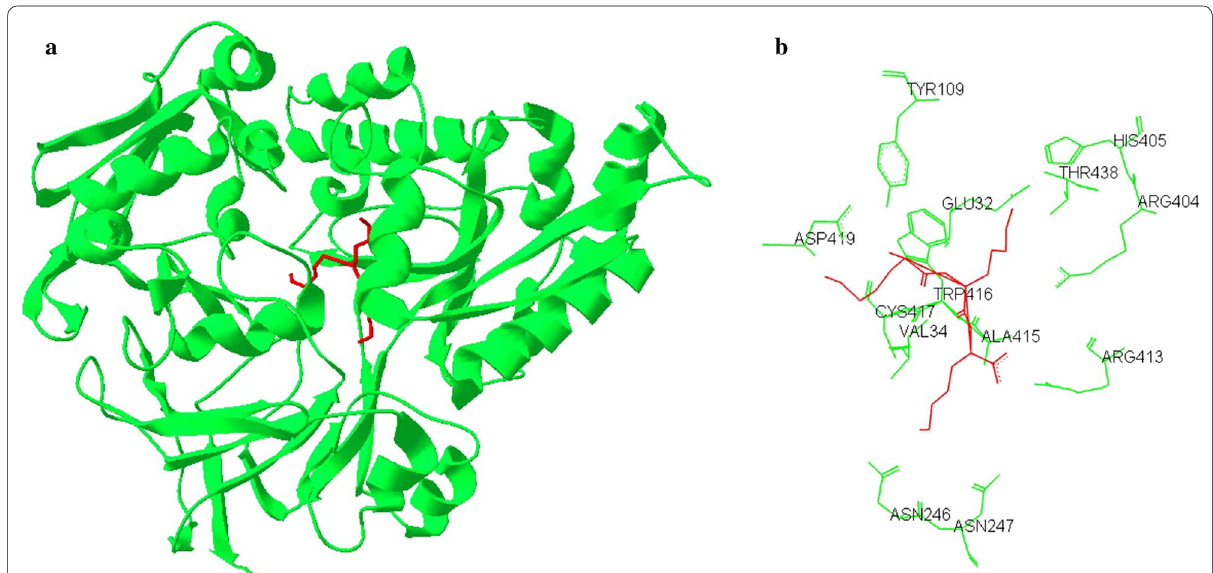
Fig. 1 Crystal structure of Y. pestis OppA protein. The OppA protein (green) is bound to tri-lysine peptide (red). PDB code: 2Z23. a The OppA protein is formed by two lobes with secondary structural βαβ units and a flexible hinge between the two lobes where the substrate-binding cleft is located. The ligand is completely enclosed in the hydrophobic cleft. b Key binding-site residues are labeled (residues Glu32, Val34, Tyr109, Asn246, Asn247, Arg404, His405, Arg413, Ala415, Trp416, Cys417, Asp419, and Thr438). Modified from (Tanabe et al.